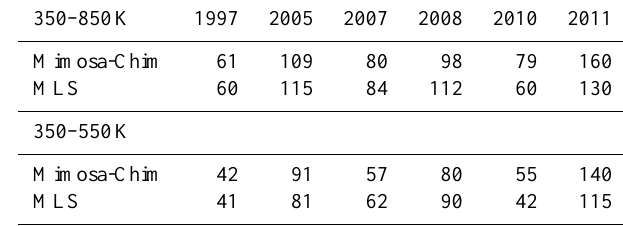
Table 1. Vortex-averaged ( ≥ 65 ◦ , Equivalent Latitude) partial col- umn ozone loss (DU) estimated over 350–850K and 350–550K from the MLS sampling inside the vortex and corresponding Mimosa-Chim simulations. Here the winter 1996/1997 is 1997